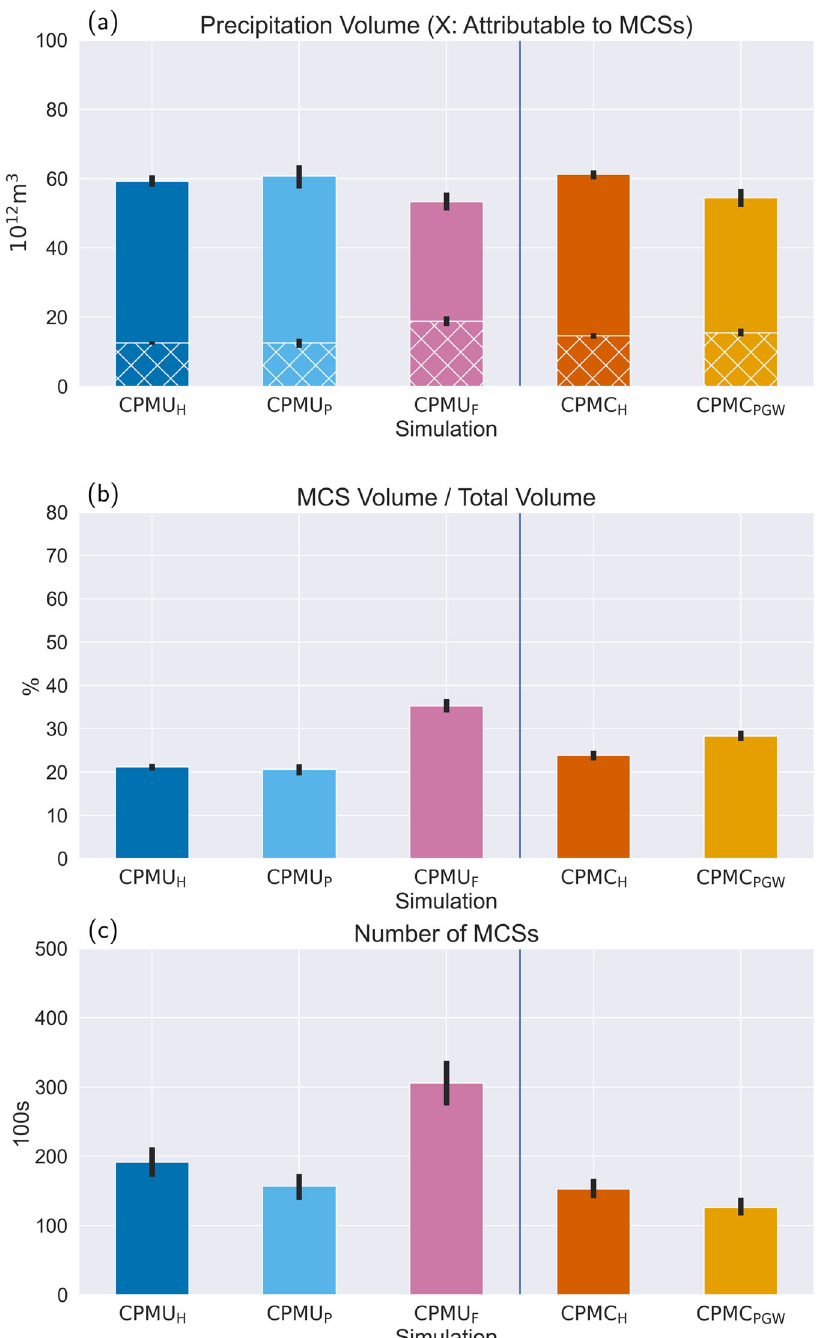
Fig. 1 Ten-year total precipitation volume attributable to MCSs across Europe and their counts. Here we show a total precipitation volume calculated from daily mean precipitation plus the part that is attributable to MCS (cross-hashed area), b the percentage contribution from MCSs, and c the number of MCSs. Black lines are the 95% CIs, estimated by year-block bootstrapping 1000